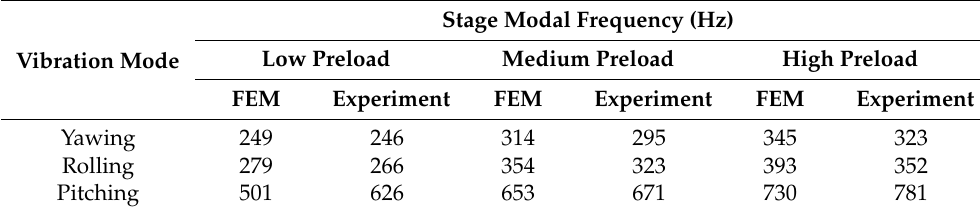
Table 3. Modal frequencies of positioning stage with different